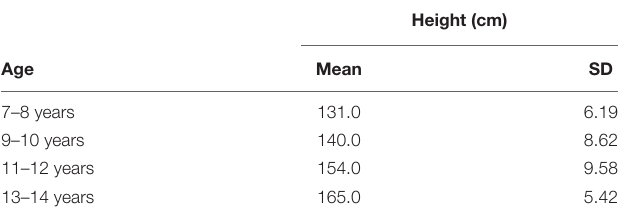
TABLE 2 | Distribution of height in different age ranges.